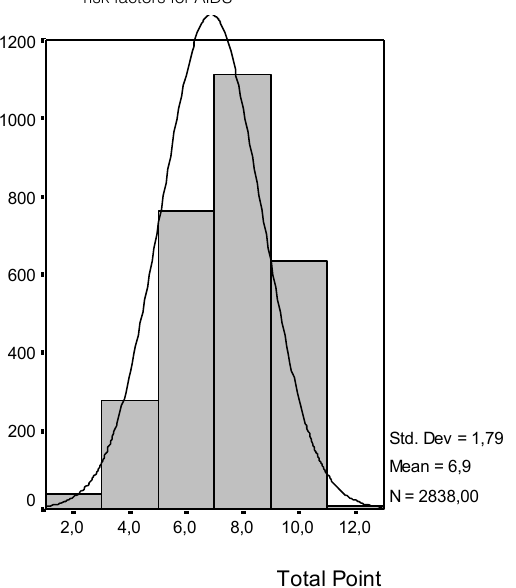
Figure 4 Distribution of knowledge levels of the students about the risk factors for AIDS